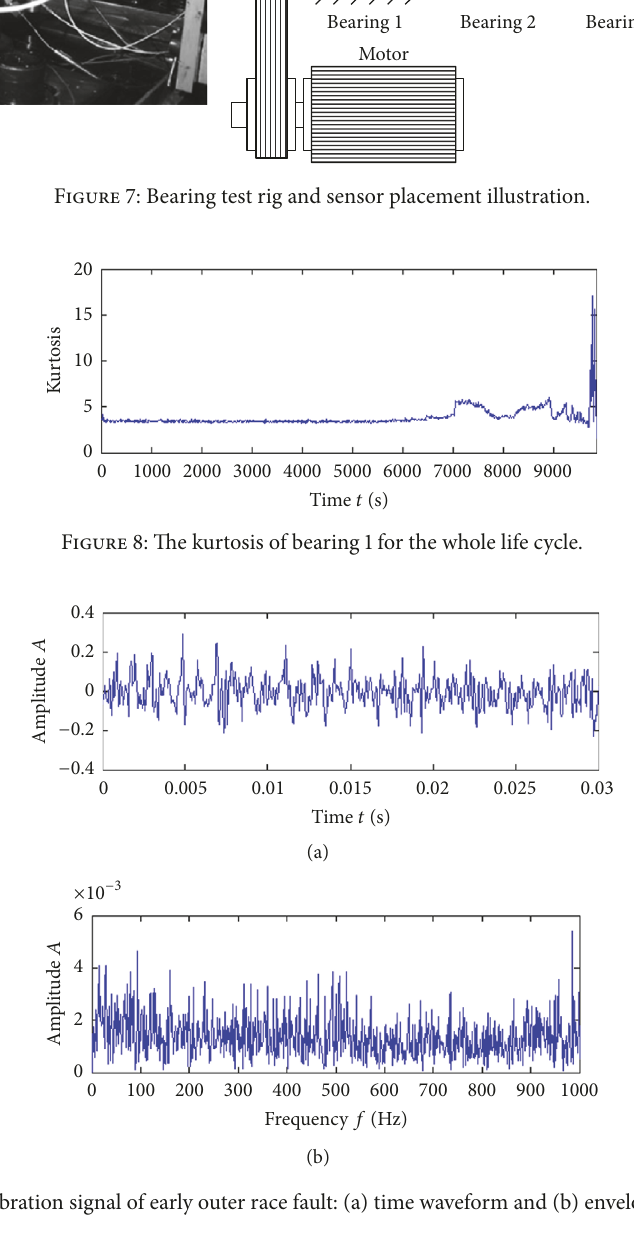
Figure 8 indicates that the period from 0 to 6900 minutes is the early stage of the damage propagating process in the entire life